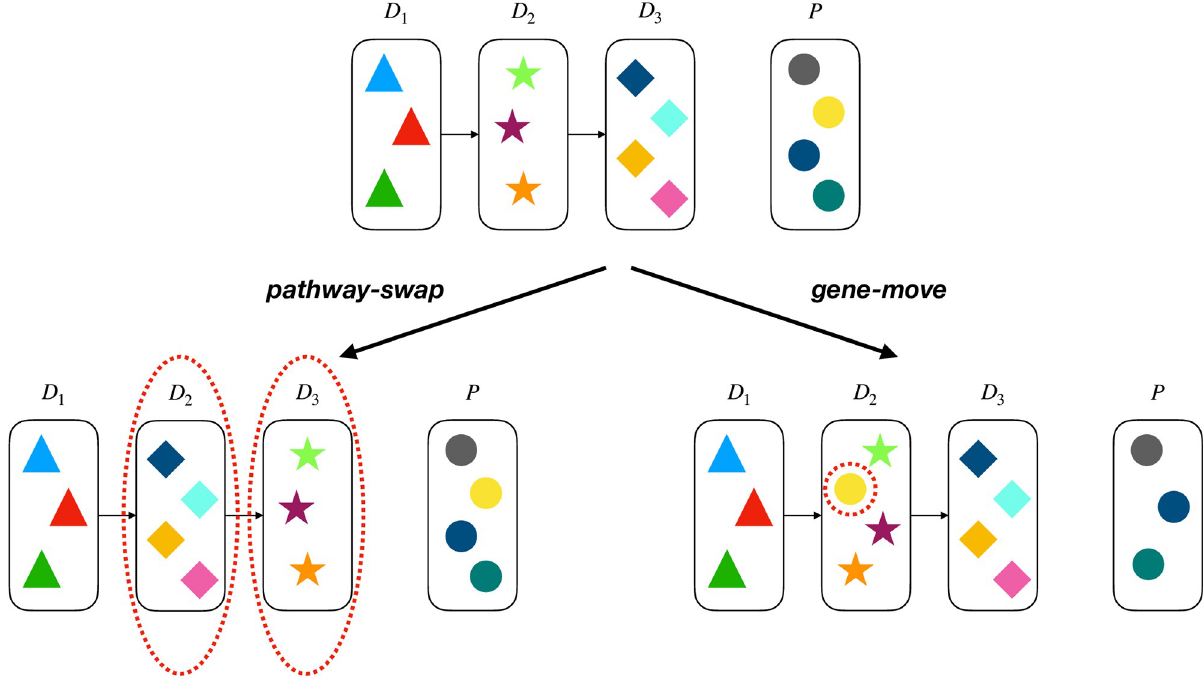
Fig 3. Two types of moves we use for progression model